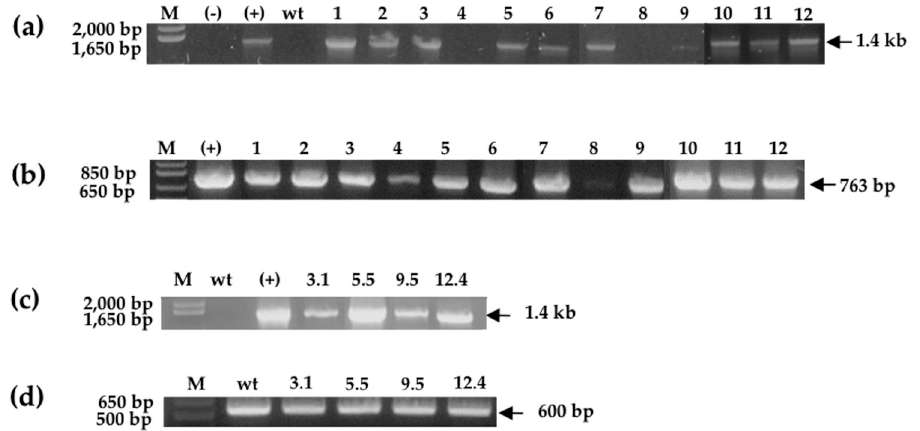
Figure 2. Molecular analysis of tobacco transgenic plants. ( a , b ) Primary transformant plants were analyzed for the presence of SmchiC and nptII genes by PCR amplification. Lane 1–12; transgenic tobacco lines, (-) water amplification control; ( + ) positive control (p2x35SChiC) vector; WT wild-type plant (negative control); M, molecular markers. ( c , d ) chitinase and actin expression by RT-PCR in homozygous transgenic plants. Transformed tobacco lines, namely lines 3.1, 5.5, 9.5 and 12.4; wt wild-type plant (negative control); M, molecular marker.